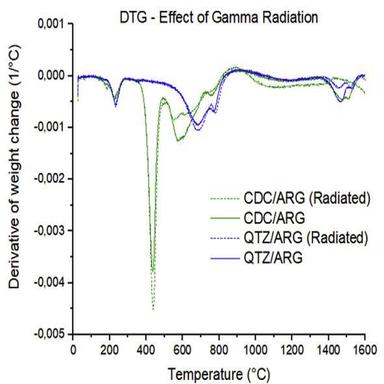
Derivative of the weight loss curves before and after gamma radiation exposure.